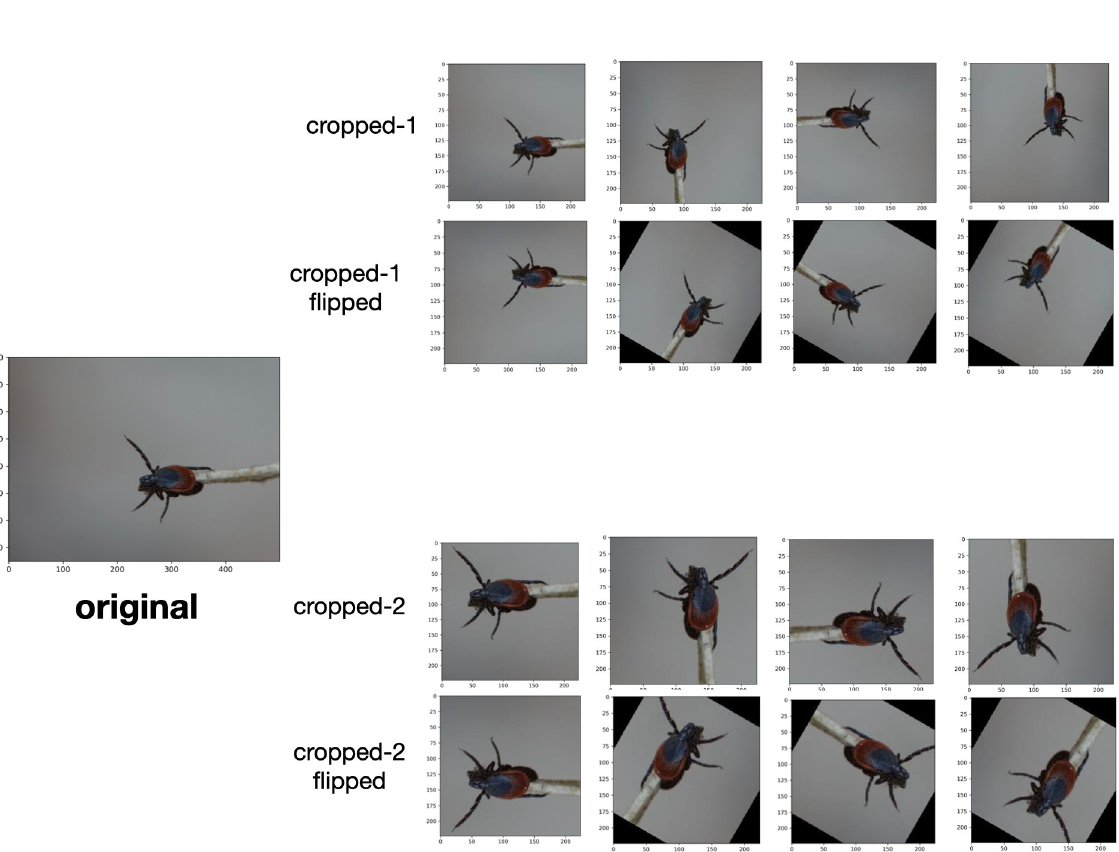
Fig 3. Image augmentation procedure to increase the size of the user-generated training dataset. Each image was re-cropped, flipped, and rotated to generate 15 visually distinct images. This process increased the size of the training dataset from 7,625 to 95,119 images.